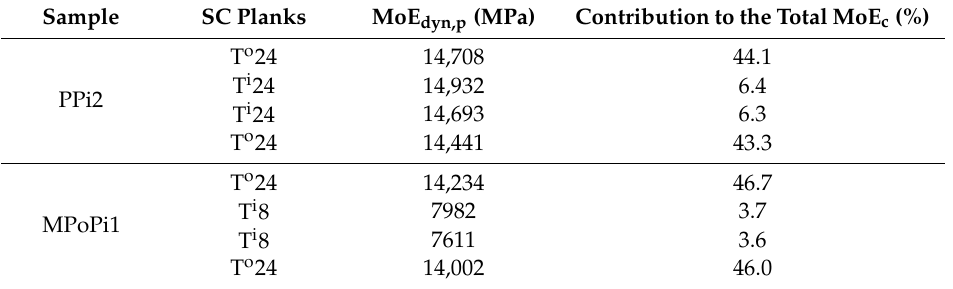
Table 3. Parallel Axes theorem results for the single-species pine PPi2 and mixed poplar / pine MPoPi1 samples. T o : Outer planks. T i : Inner planks. MoE dyn,p : dynamic modulus of elasticity of each